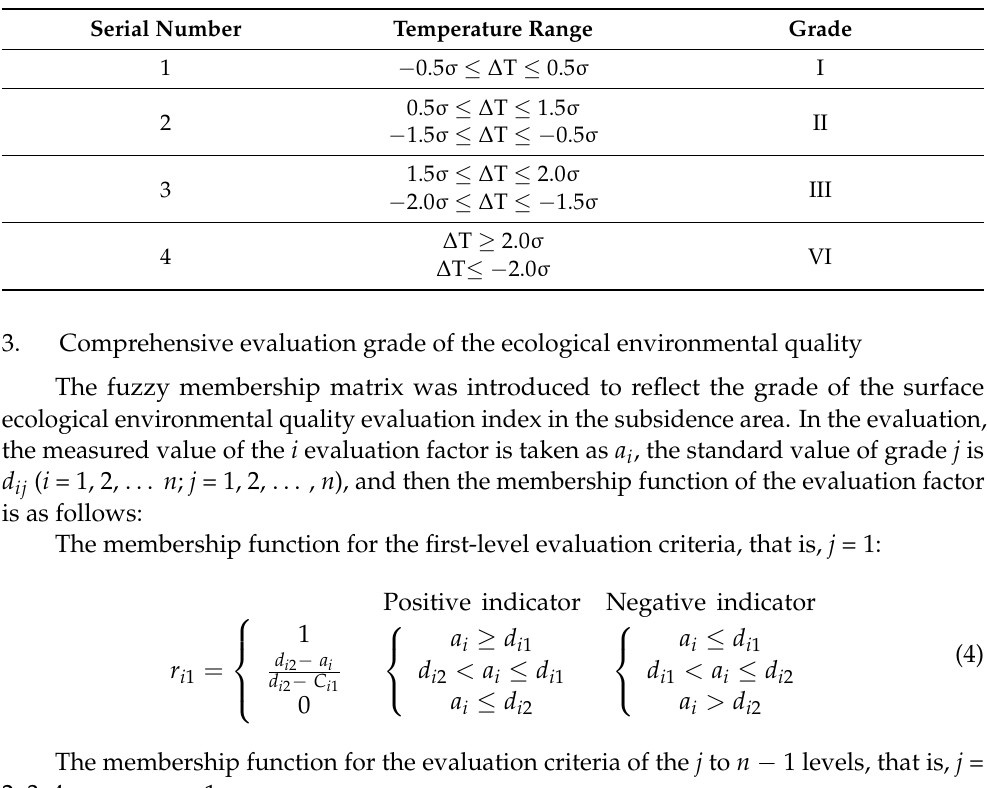
Table 3. The annual average temperature grade